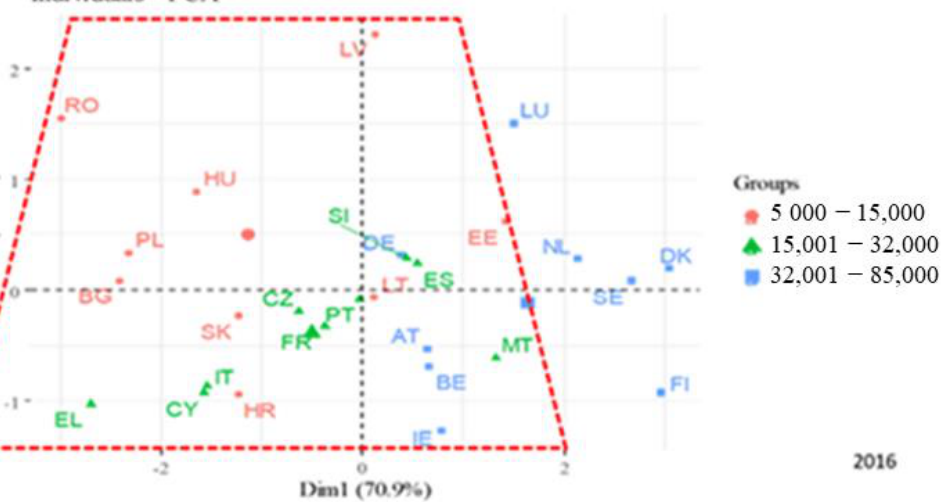
Figure 8. The position of countries on the plane of principal components (grouped by the real GDP in euro per capita),